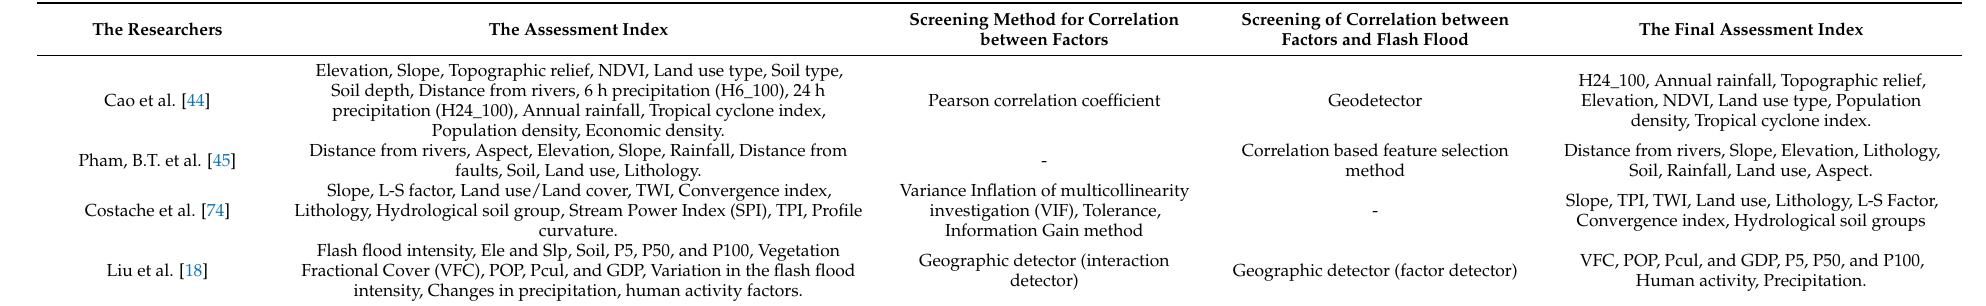
Table 9. Research on the screening of representative assessment indexes.